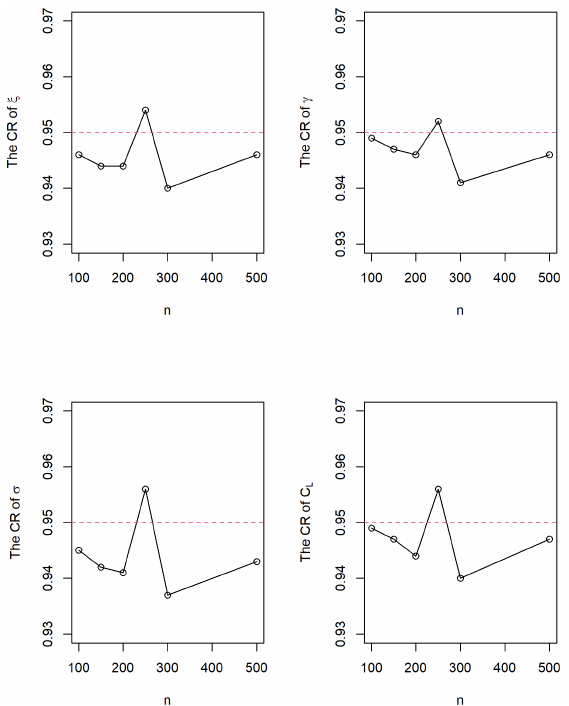
Figure 1. The CRs for estimating ξ , γ , σ , and C L through using the PBP and BCP methods. The dashed line is the nominal